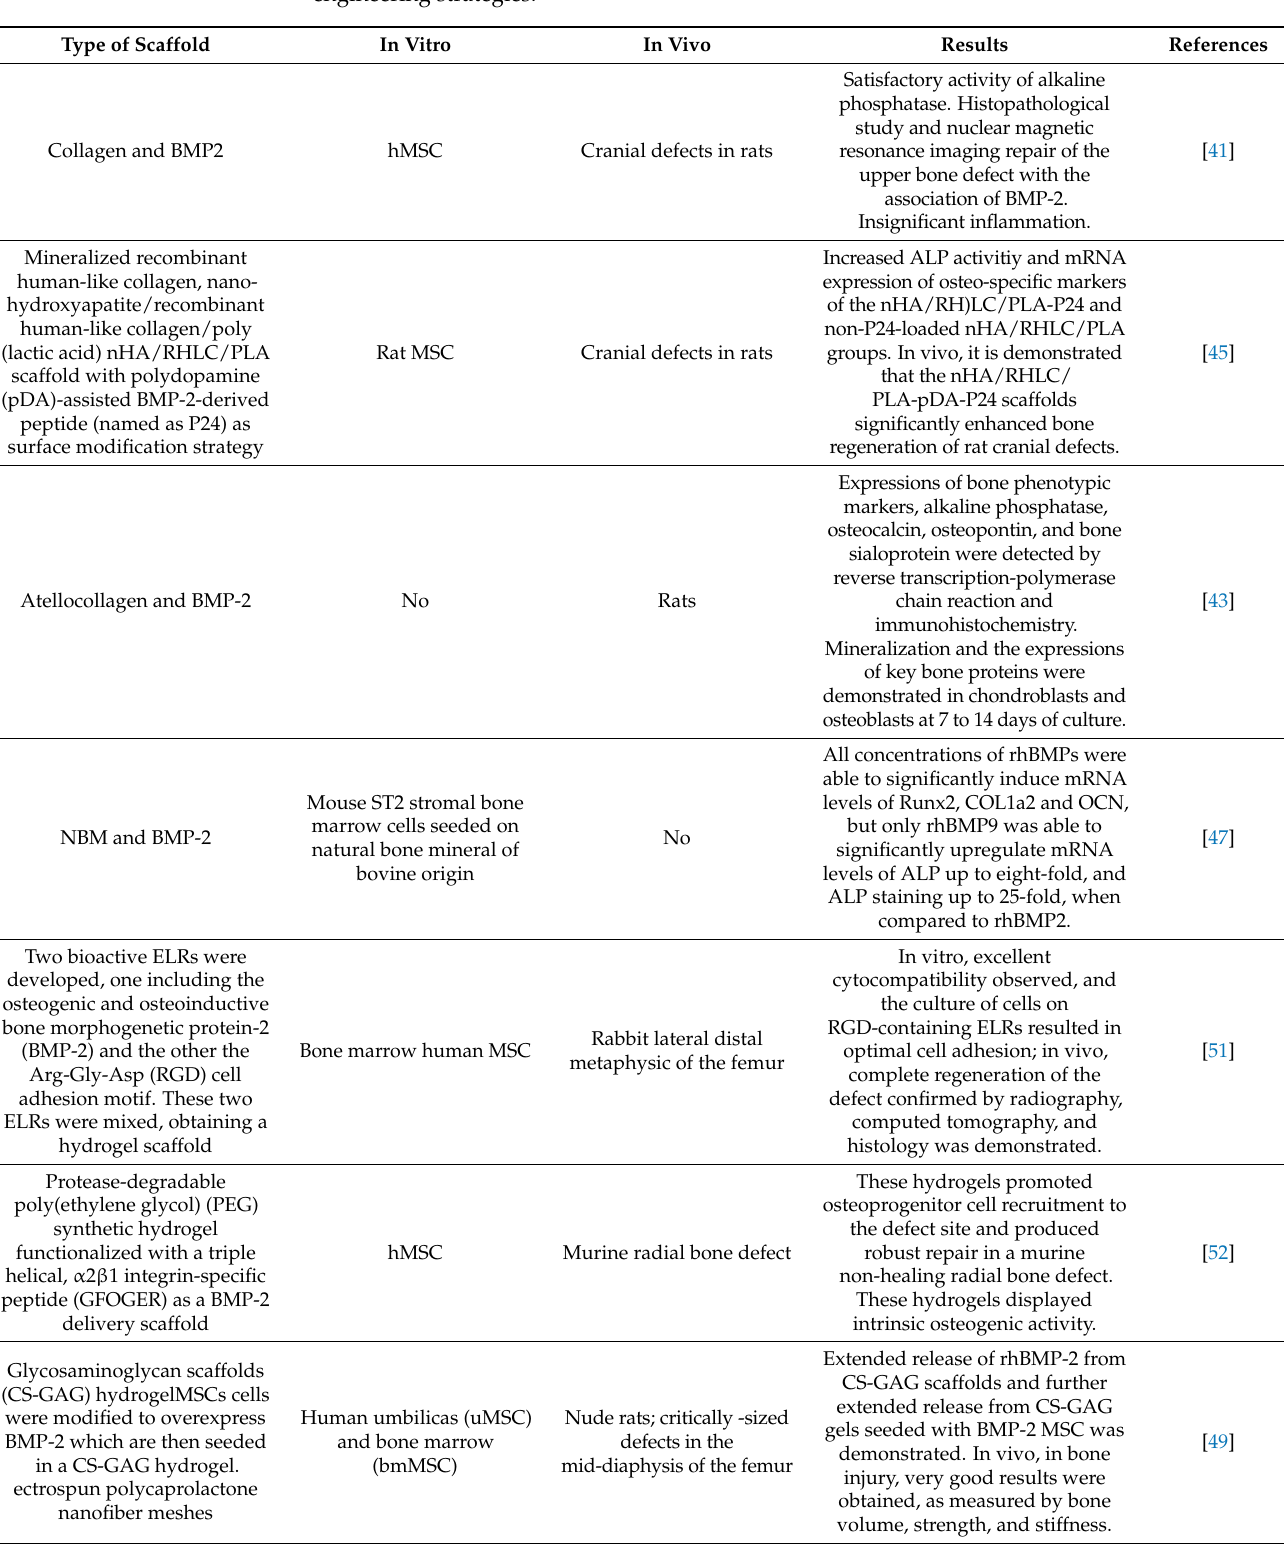
Table 1. Outstanding work applying recombinant bone morphogenetic proteins (BMPs) in tissue engineering